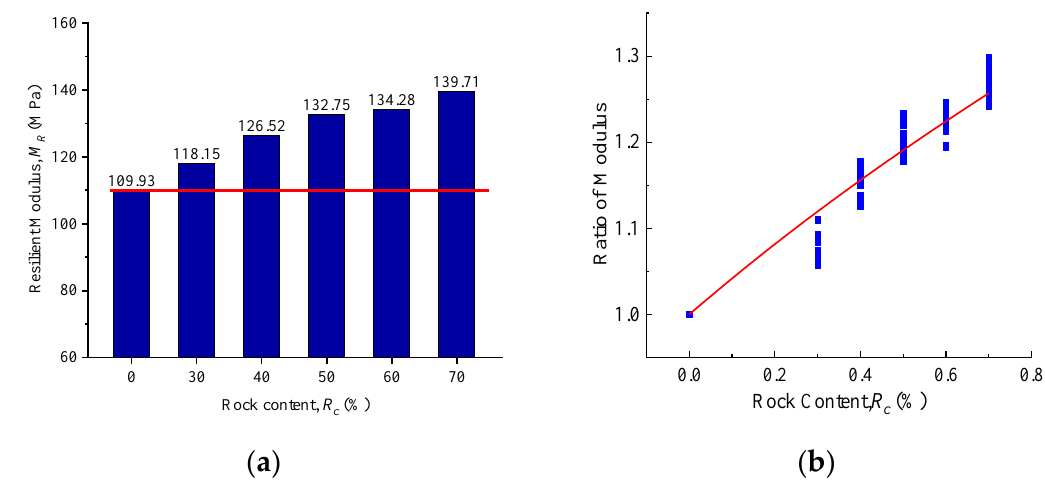
Figure 3. Parametric variation with rock content: ( a ) resilient modulus; ( b ) ratio of modulus.